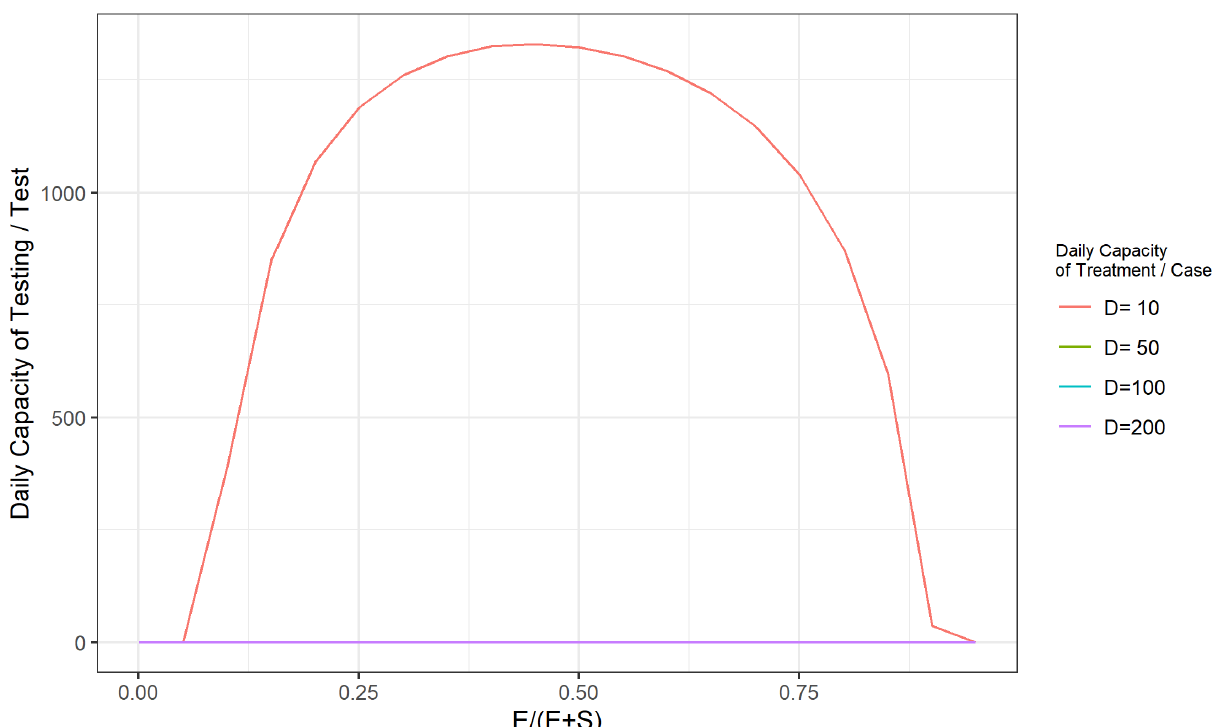
Figure A11. The effect of daily testing capacity on the ability to control the potential development level of the epidemic ( S + E = 3000, I = 1000).